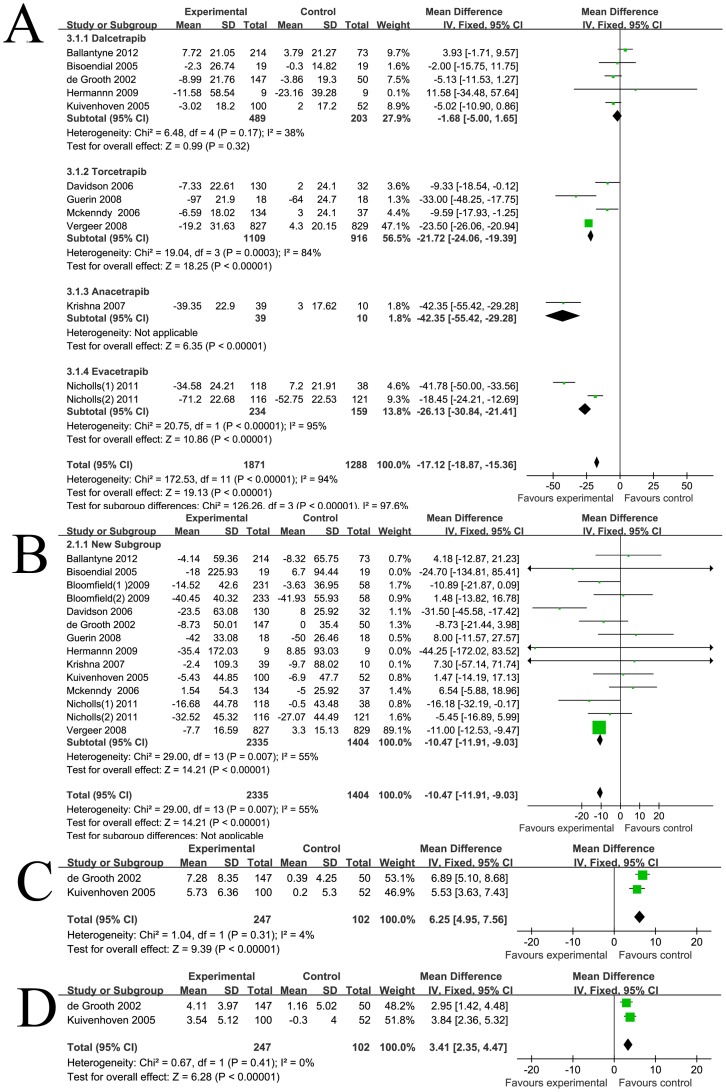
Forest plots depicting the effect of CETP inhibitors on lipid parameters (grouped by different CETP inhibitors) A: LDL-c; B: TG; C: HDL2; D: HDL3.